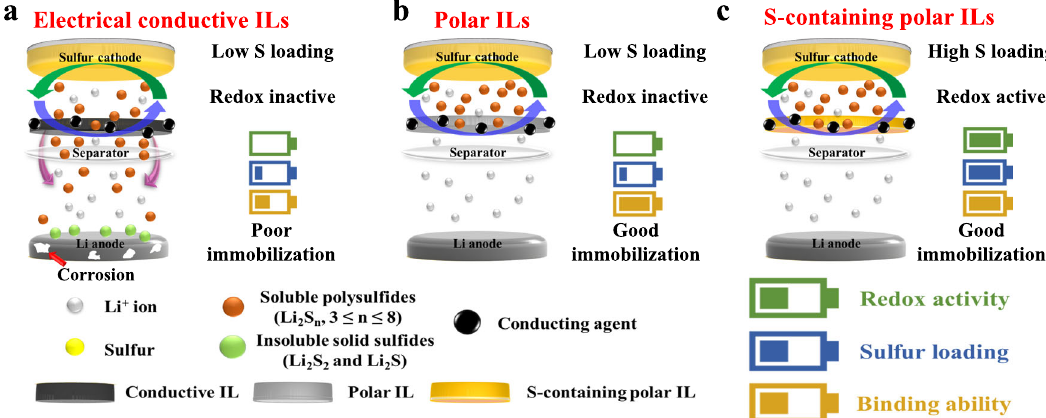
Fig. 1 Design rationale of redox-active ILs. a – c , Illustration of Li-S batteries with ( a ) electrical conductive, ( b ) polar, and ( c ) S-containing polar interlayers